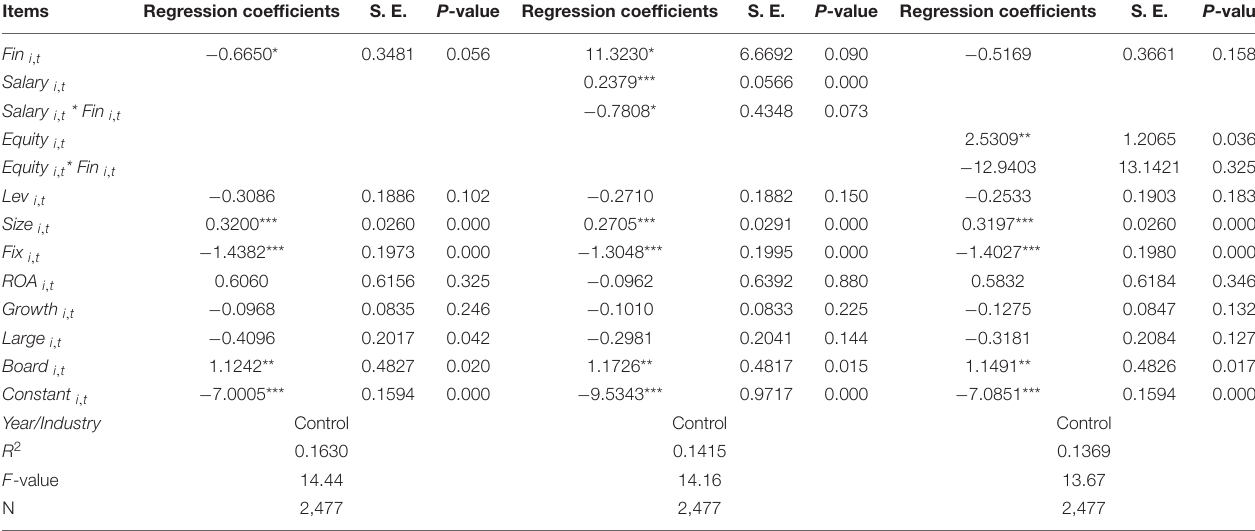
TABLE 13 | The regression results of property heterogeneity (state-owned enterprises).